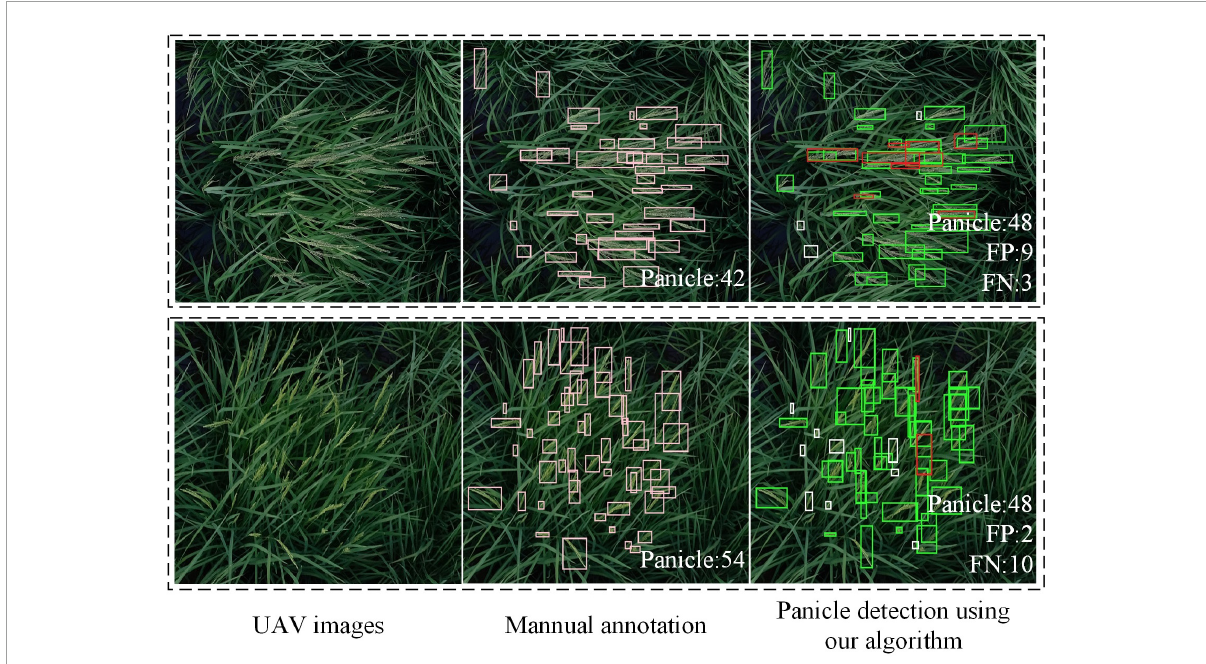
FIGURE10 Detection results of field images taken by UAV. In the detection results, green boxes are correct bounding boxes; white boxes are FN boxes; red boxes are FP boxes.